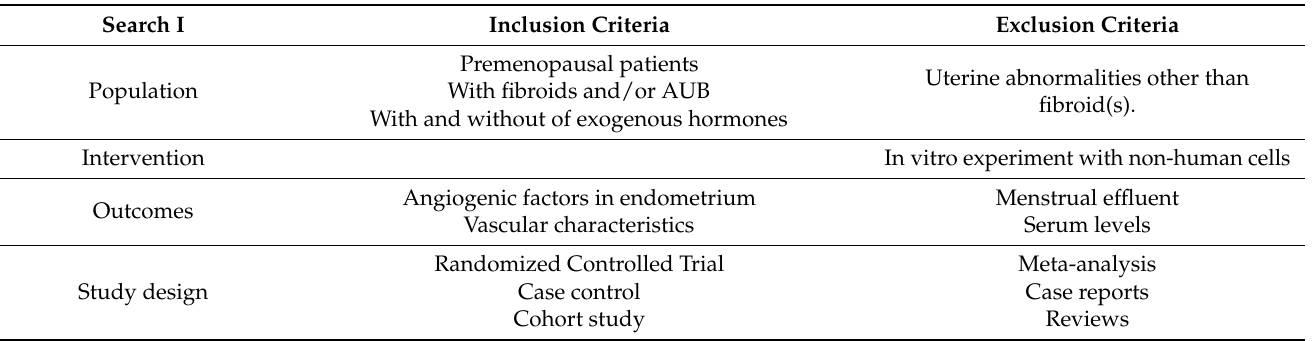
Table 2. Inclusion and exclusion criteria of Search I and